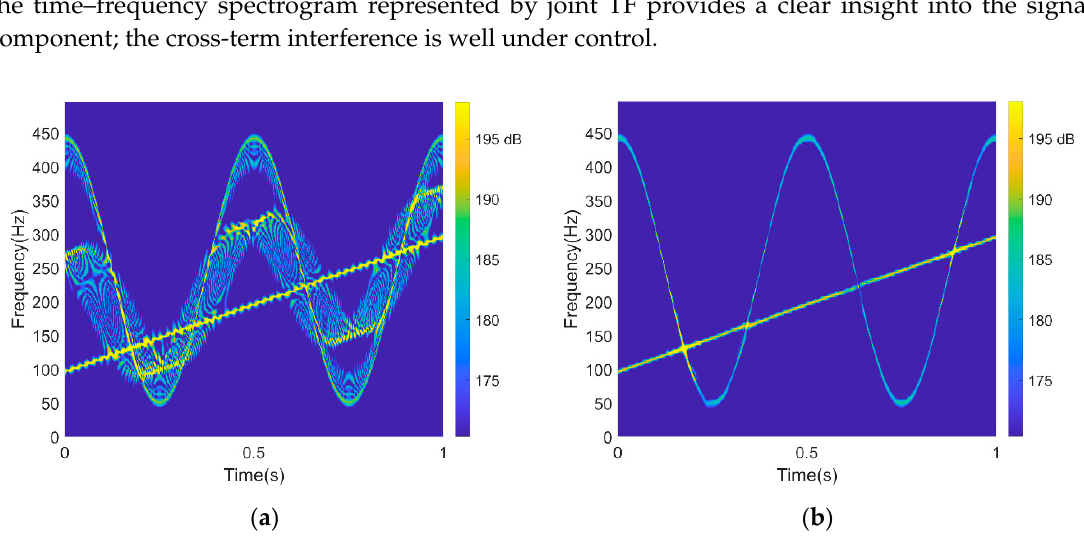
Figure 2. Time–frequency representations of the composite signal by ( a ) Wigner–Ville distribution (WVD) and ( b ) joint TF representation.